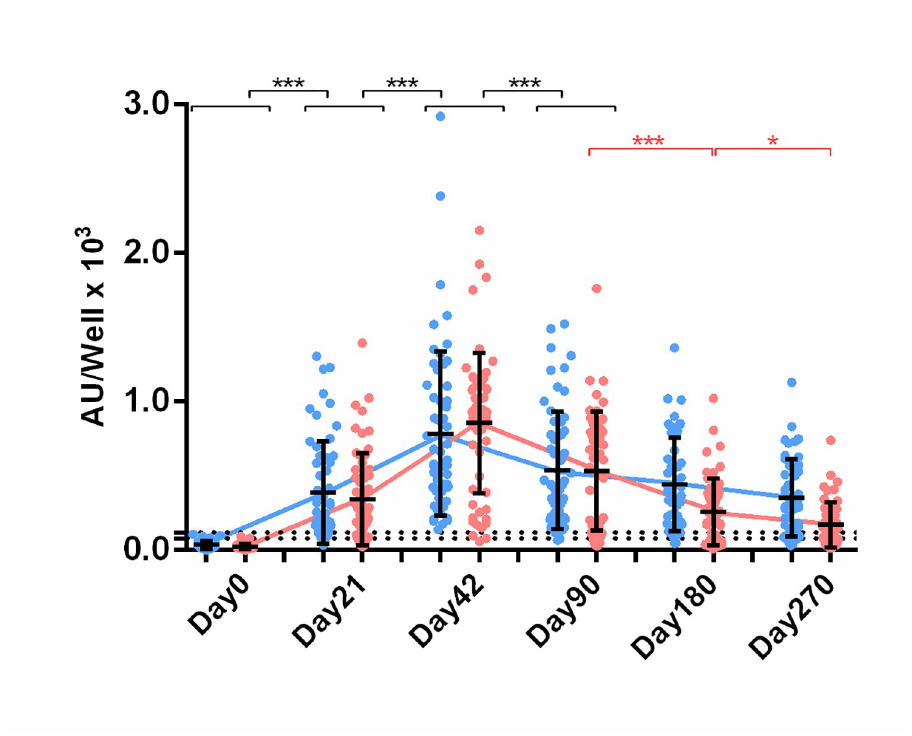
Fig 4. IgA anti-S and anti-RBD levels post-vaccination. Anti-S (blue) and anti-RBD (red) Abs were measured on Day0, 21, 42, 90, 180 and 270 (n = 56). Cut-off values for anti-S and anti-RBD Abs were 120 AU/well and 80 AU/well, respectively (dashed lines). Asterisks ( ��� ) indicate statistically significant differences ( p -value < 0.001) between the compared groups. Each dot represents an individual, and error bars represent the mean value and standard deviation of the distribution.